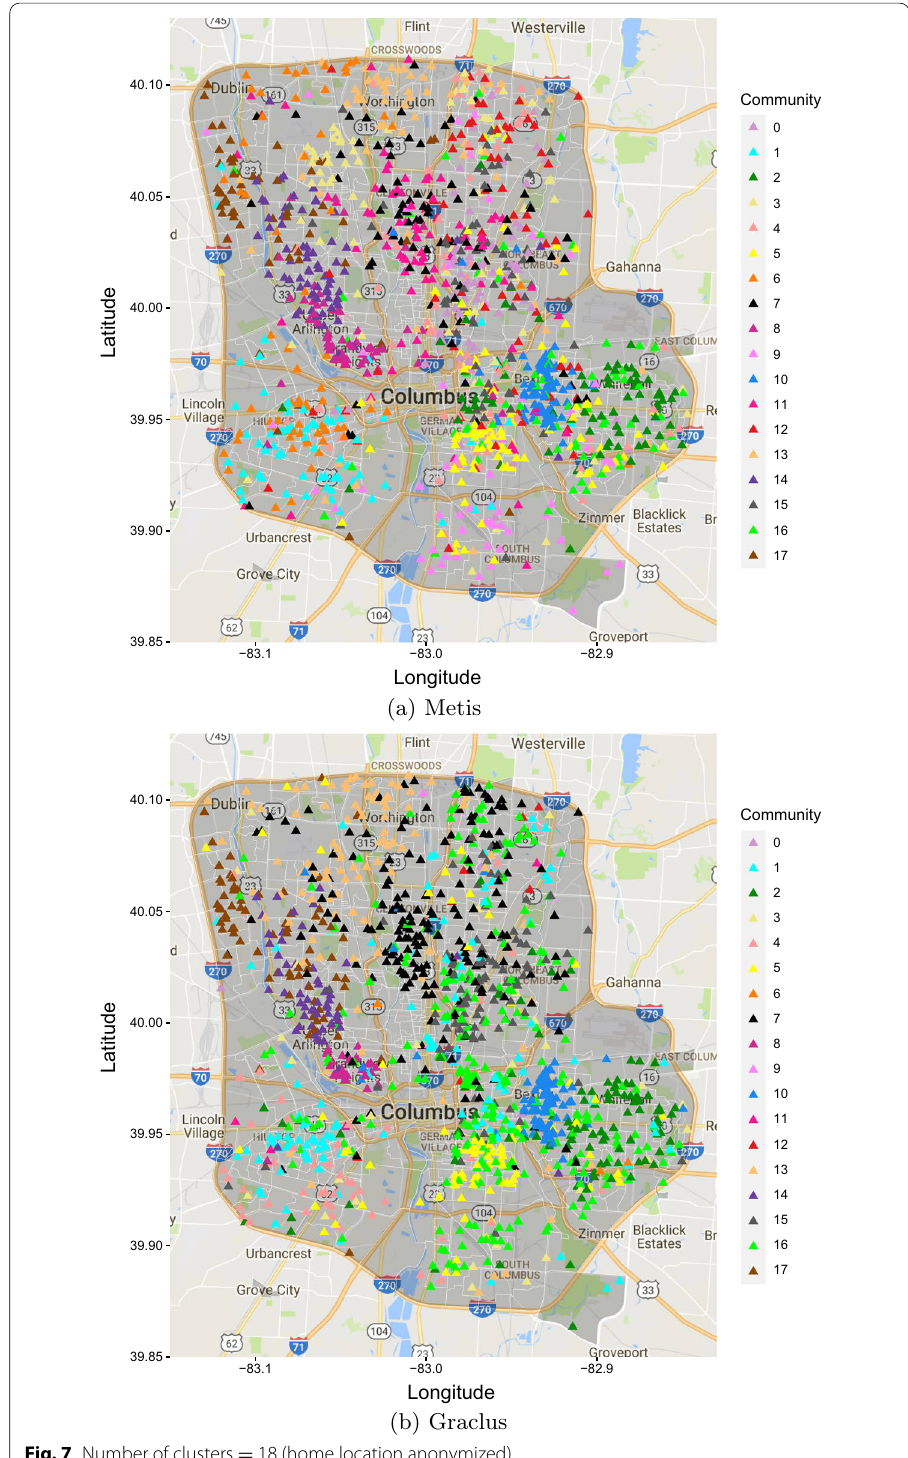
Fig. 7 Number of clusters